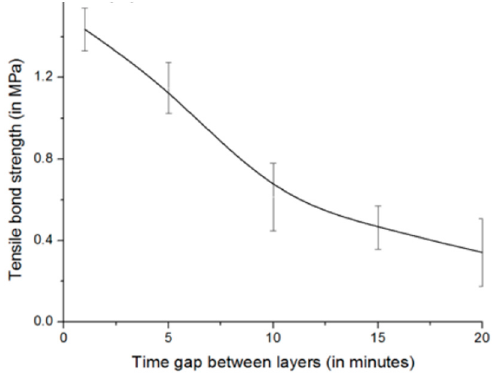
Figure 18. Effect of time gay between layers on tensile bond strength, [43]. Figure 18. . Effect of time gay between layers on tensile bond strength. Reprinted with permission from ref. [43]. Copyright 2017 Elsevier